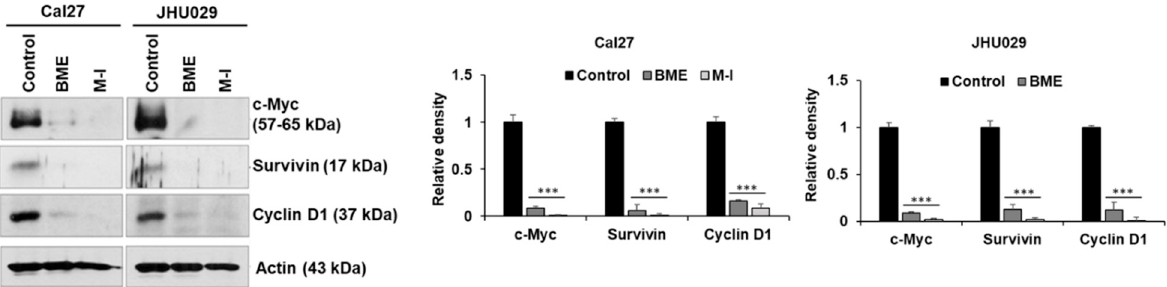
Figure 3: Momordicine-I inhibits downstream of c-Met signaling in HNC cells. Representative Western blot image for c-Myc, survivin and cyclin D1 expression in Cal27 and JHU029 cells with treatment of BME or M-I. The same membrane used in panel A was reprobed. Actin was used as internal control. Quantitative representation of Western blot band intensities (right panel). Small bar indicates standard error (*** p < 0.001). Uncropped western blots figures are shown in Figure S5.